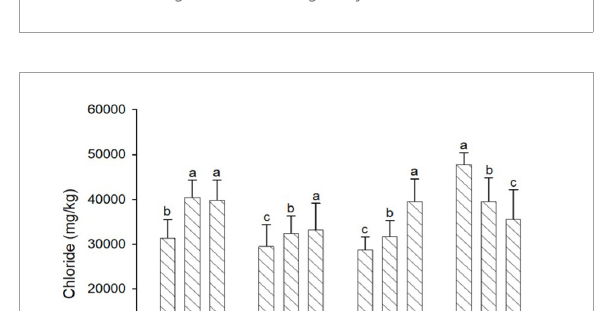
FIGURE2 Concentration (mg/kg DW) of Se in plants of agretti grown for 4 years on saline, B- and Se-laden soil and irrigated at different rates (Et o %) with either low-saline water (2016 and 2017) or saline water (2018 and 2021). Statistical difference was performed to analyze the effect of irrigation levels within each planting year (H100 = high 100% Et o , M75 = medium 75% Et o , and L50 = low 50%Et o ), as described in Table 3 . Values represent average ( n = 12 for 100% Et o , n = 9 for 75% and 50% Et o for planting in 2016; n = 19 for 100% Et o , n = 17 for 75% for planting in 2017; n = 18 for planting in 2018, n = 4 for planting in 2021, direct seeding) and error bars represent standard deviation. There was no significance amongst any treatments.